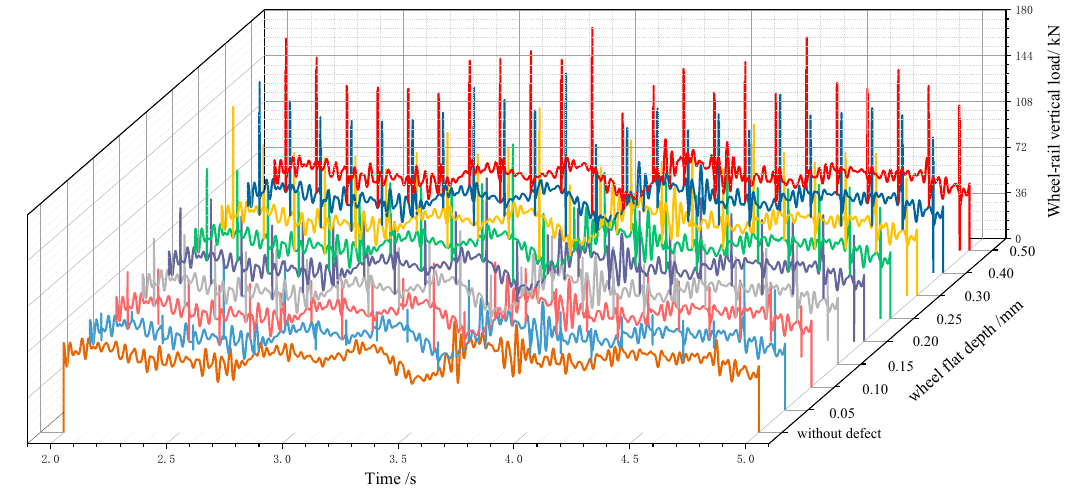
Figure 4. Wheel-rail force curves with wheel flats of different depths.